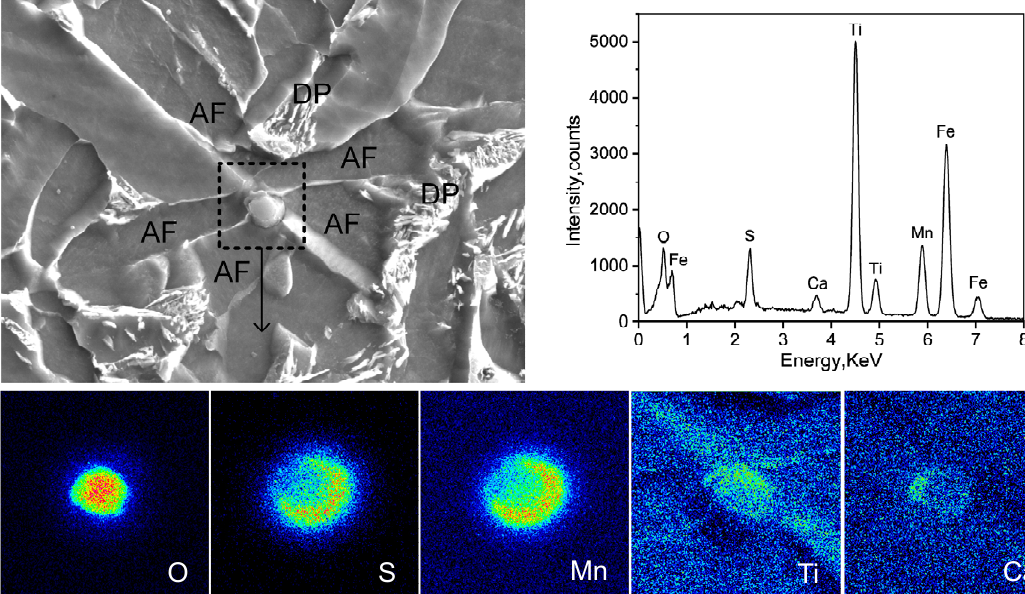
Figure 7. Electron probe microanalyzer (EPMA) analysis of one typical inclusion particle effective for AF nucleation in experiment steel. AF : Acicular ferrite; DP : Degenerated pearlite.